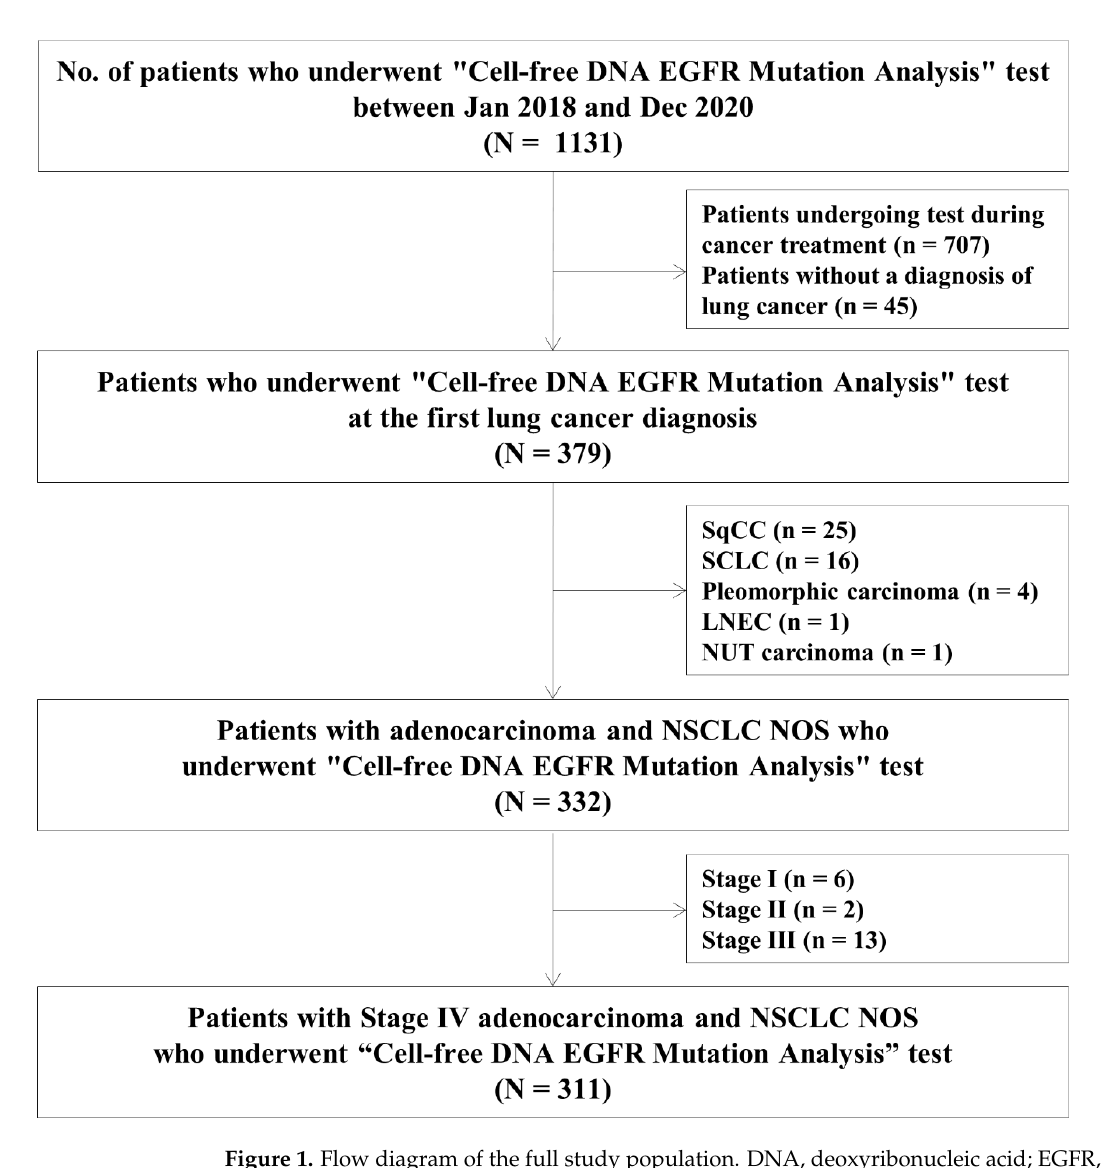
Figure 1. Flow diagram of the full study population. DNA, deoxyribonucleic acid; EGFR, epidermal growth factor receptor; SqCC, squamous cell carcinoma; SCLC, small cell lung cancer; LNEC, large cell neuroendocrine carcinoma; NSCLC NOS, non-small cell lung cancer not otherwise speci- fied. Table 1. Baseline characteristics of study subjects according to tissue and plasma EGFR mutation status (N = The prevalence of EGFR mutation was 52.7% (164/311) in this study. Of the 311 sub- jects, 147 (47.3%) had two negative tests for EGFR mutation (tissue − /plasma − ), 34 (10.9%)